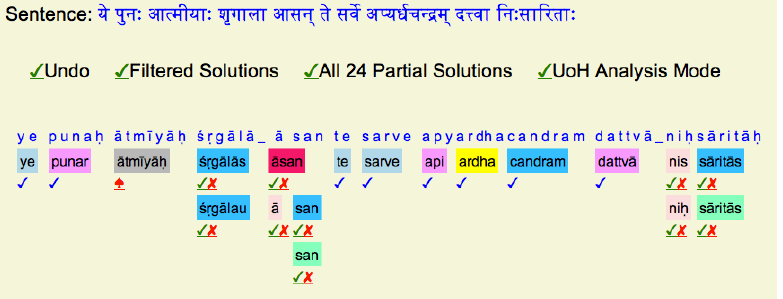
Figure 11: The partial segmentations for the sentence ye punar ātmīyāḥ śṛgālā āsan te sarve ’py ardhacandraṃ dattvā niḥsāritāḥ with the segment ātmīyāḥ remaining